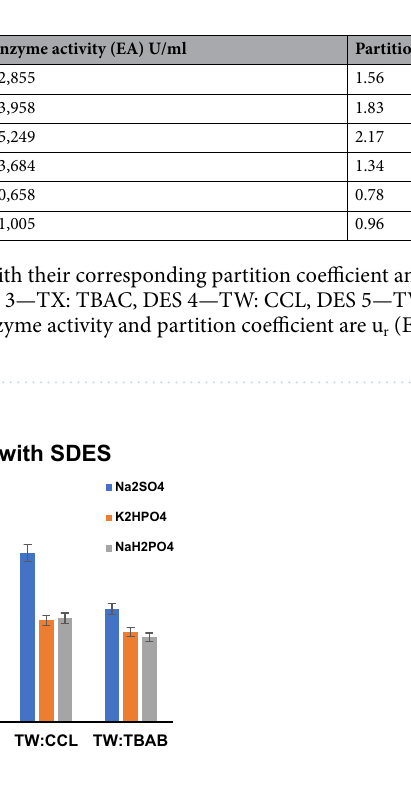
Figure 4. The partition coefficient values of various salts in combination with all six SDES under